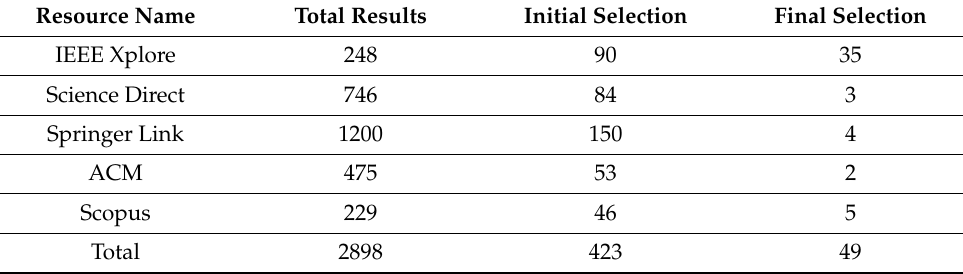
Table 2. Summary of data sources and search